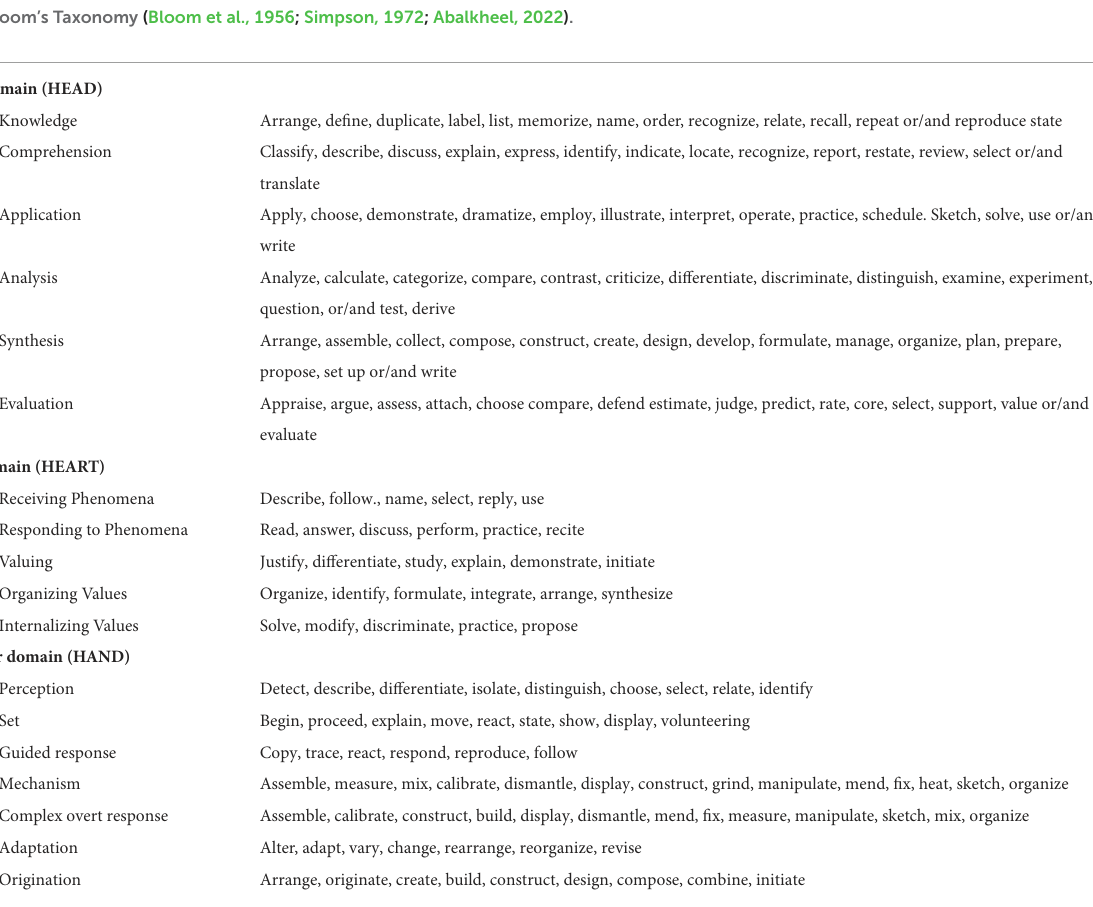
TABLE 1 Bloom’s Taxonomy (Bloom et al., 1956; Simpson, 1972; Abalkheel, 2022).